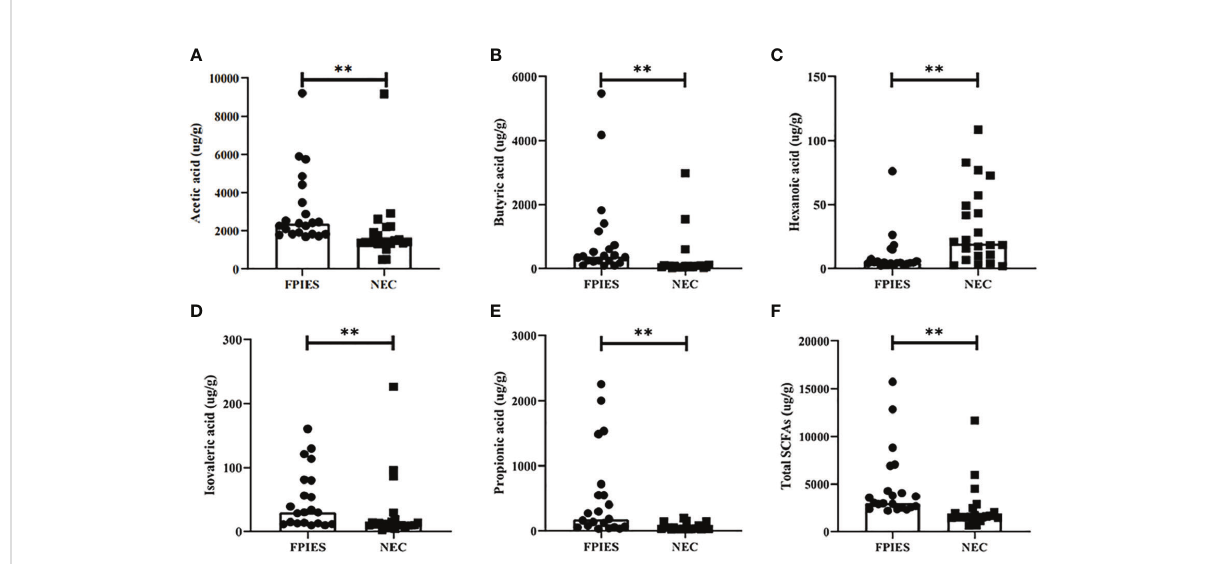
FIGURE 7 Gas chromatography-mass spectrometry (GC-MS) analysis of short chain fatty acids (SCFAs) in fecal samples from necrotizing enterocolitis (NEC) infants and food protein-induced allergic protocolitis (FPIAP). (A) acetic acid, (B) butyric acid, (C) hexanoic acid, (D) isovaleric acid, (E) propionic acid, and (F) Total SCFAs. ** P <;0.01. Data was presented as means±SEM, N =22 for NEC and N =21 for FPIAP.